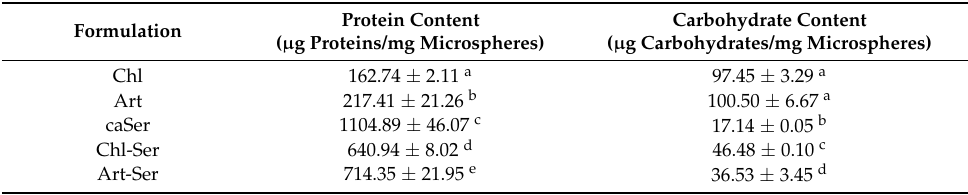
Table 2. Protein and carbohydrate contents in the resulting microspheres. Results are reported as mean values ± S.D. ( n = 3). Different letters (a, b, c, d and e) indicate significant differences between formulations ( p <